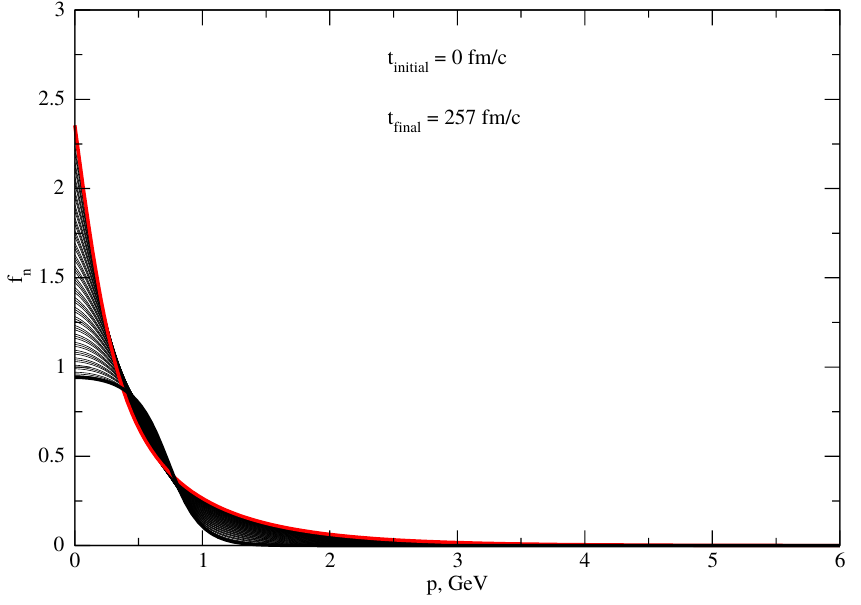
Figure 1. (Color online) The evolution of gluon distribution function f ( p ) with time in a system of massive gluons ( m = 0.7 GeV). The final distribution is shown as a bold red line, while the initial function is drawn as a bold black line. Thin black lines represent the intermediate stages of the gluon distribution function. The final time of the evolution represents the point when the pion distribution reaches